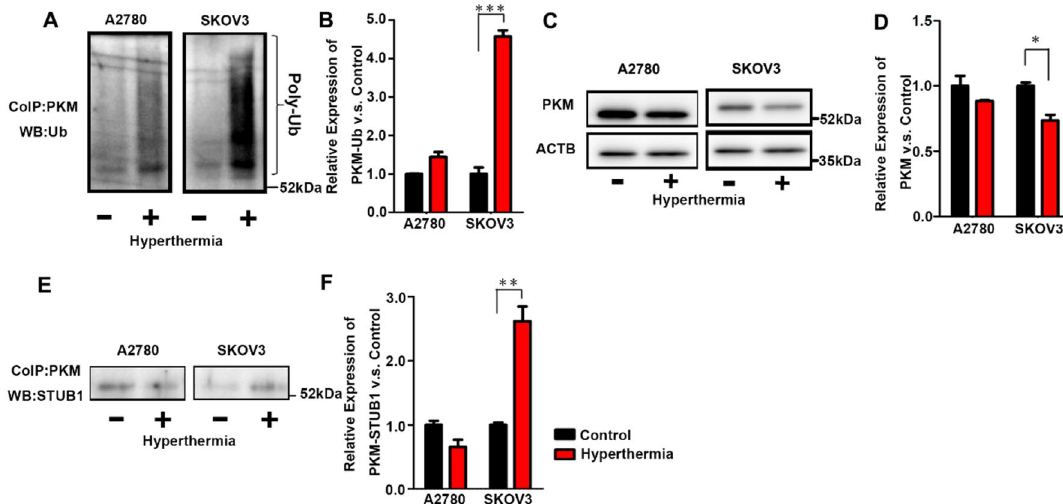
Figure 3. Ubiquitination and degradation of PKM. ( A ) Western blot analysis of ubiquitin after co-immunoprecipitation of PKM in A2780 and SKOV3 cells treated with hyperthermia (46 °C, 1 h). ( B ) Quantitative analysis of Ubiquitinated PKM1/2. ( C ) Western blot analysis of PKM1/2 in A2780 and SKOV3 cells treated with hyperthermia (46 °C, 1 h). ( D ) Quantitative analysis of PKM1/2. ( E ) Western blot analysis of STUB1 after co-immunoprecipitation with PKM1/2 in A2780 and SKOV3 cells treated with hyperthermia (46 °C, 1 h). ( F ) Quantitative analysis of PKM1/2 binding STUB1. Average ± S.D.; n = 3. *P < 0.05; **P < 0.01; ***P < 0.001. N.S.: Not significant